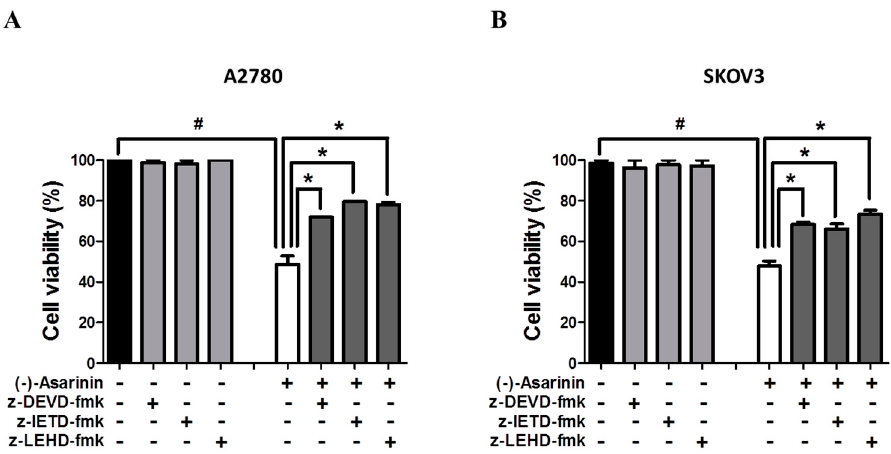
Figure 4. The effect of caspase inhibitors on ( − )-asarinin ( 1 )-induced cell death in human ovarian cancer cells. A2780 ( A ) and SKOV3 ( B ) cells were pretreated with caspase-3 inhibitor z-DEVD-fmk (50 µ M), caspase-8 inhibitor z-IETD-fmk (50 µ M), and caspase-9 inhibitor z-LEHD-fmk (50 µ M) for 30 min, and then treated with the indicated concentration (A2780; 40 µ M and SKOV3; 60 µ M) of ( − )-asarinin ( 1 ) for 48 h. A MTT (3-(4,5-dimethylthiazol-2-yl)-2,5-diphenyl-tetrazolium bromide) assay was performed to determine the cell viability after ( − )-asarinin ( 1 ) treatment. Statistical significance was determined by Student’s t -test. # p < 0.05 as compared with the untreated group and * p < 0.05 as compared with the ( − )-asarinin ( 1 ) only-treated group.